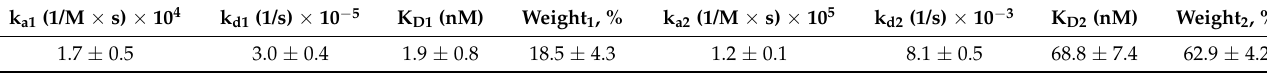
Table 1. Apparent equilibrium dissociation constants (KD) for the interaction between [ 99m Tc]Tc-AC12- GGGC and SKOV-3 cells determined using an InteractionMap analysis of the LigandTracer sensorgrams.